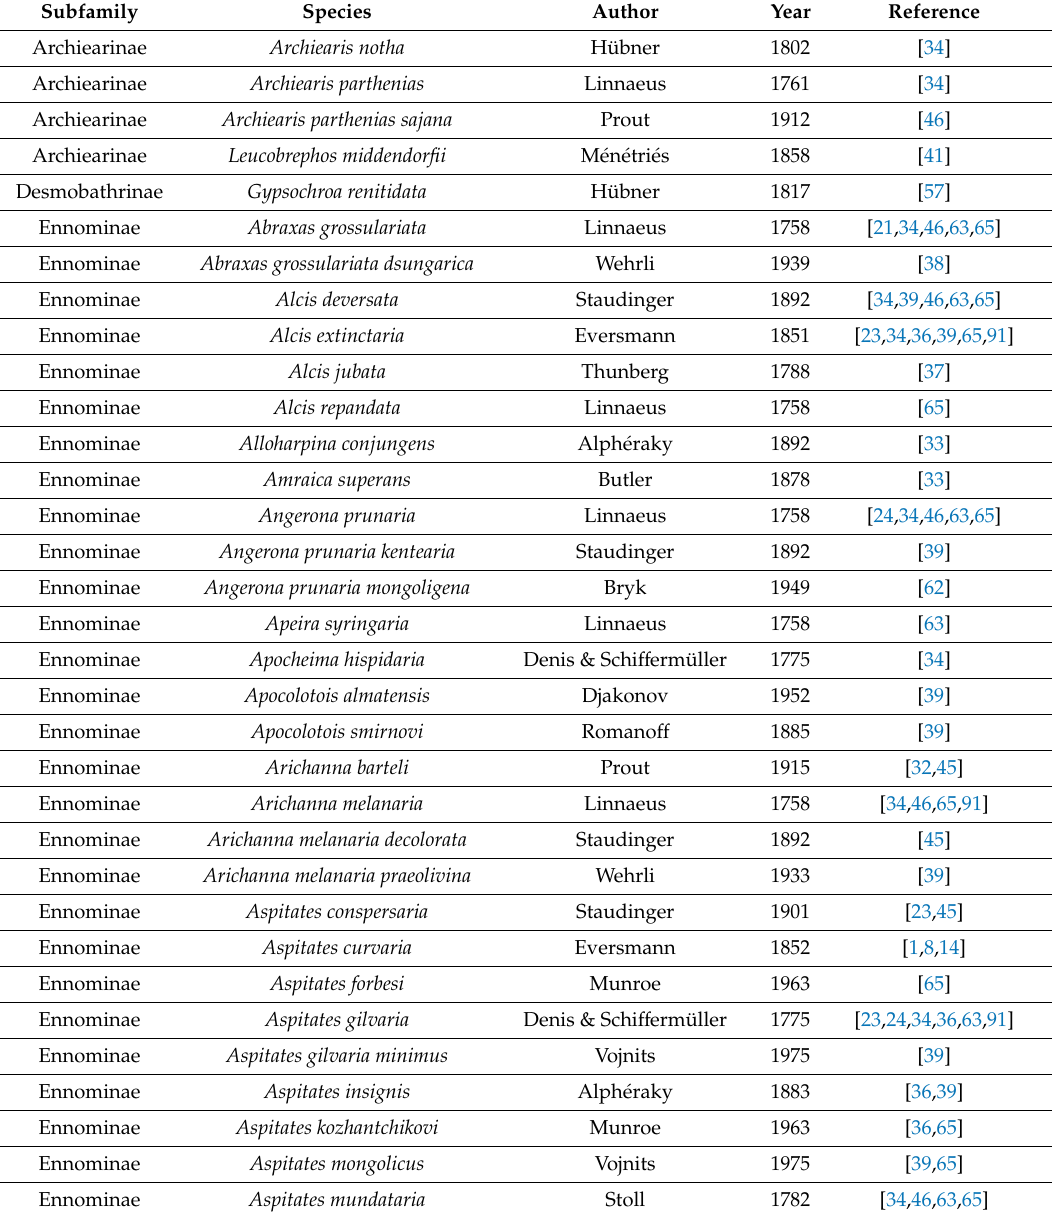
Table A1. Checklist of geometrid moths in Mongolia. Note that we conducted all analysis at species level. Here subspecies are listed to show compiled data in more detail. The listed references include in most cases articles with location